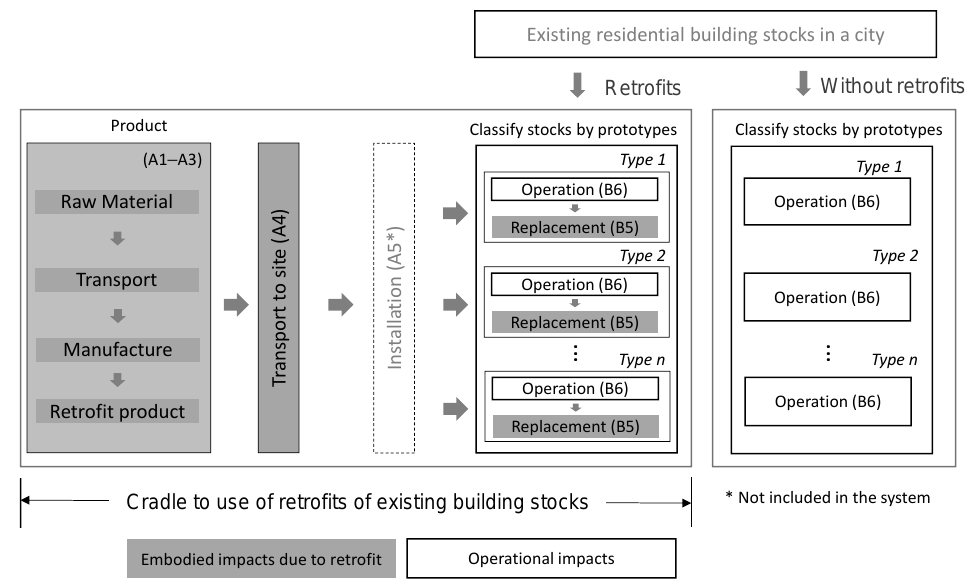
Figure 1. Overview of the system boundary in this study. The carbon footprint in the energy retrofit program consists of the GHG emissions embodied in building product manufacturing (A1 – A3 in EN15978 [32]), transportation associated with the building renovation process (A4) and product replacement (B5) over the life of the building together with the GHG emissions associated with the energy used during the building operation stage (B6). (A5 is not included in this system).